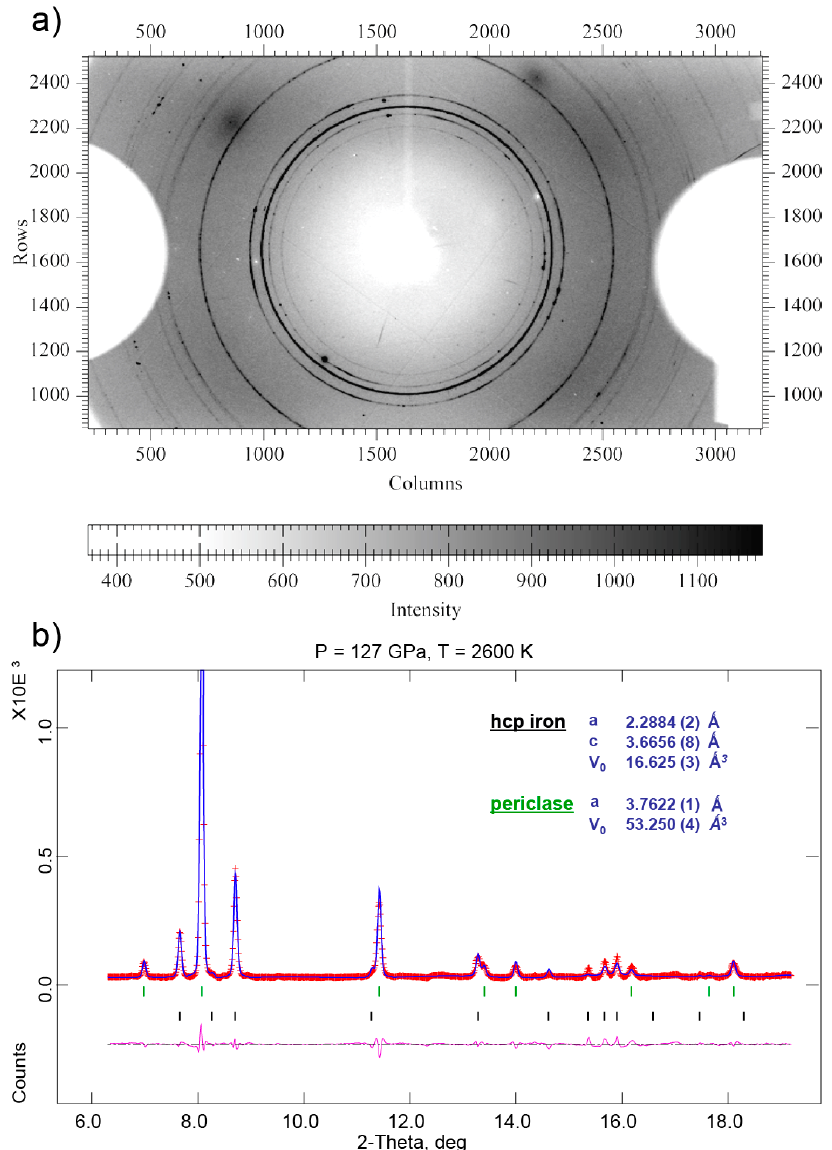
Figure 1. Example of the collected data at high pressure and high temperature. ( a ) Two dimensional (2D) diffraction image recorded on the MAR 345 image plate; ( b ) integrated diffraction pattern of hcp iron along with the Le Bail refinement with the General Structure Analysis System (GSAS) package, presented here after background subtraction.